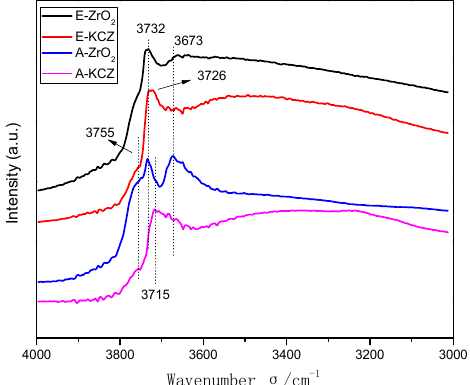
Figure 4. Infrared spectra of ZrO 2 -based catalysts.